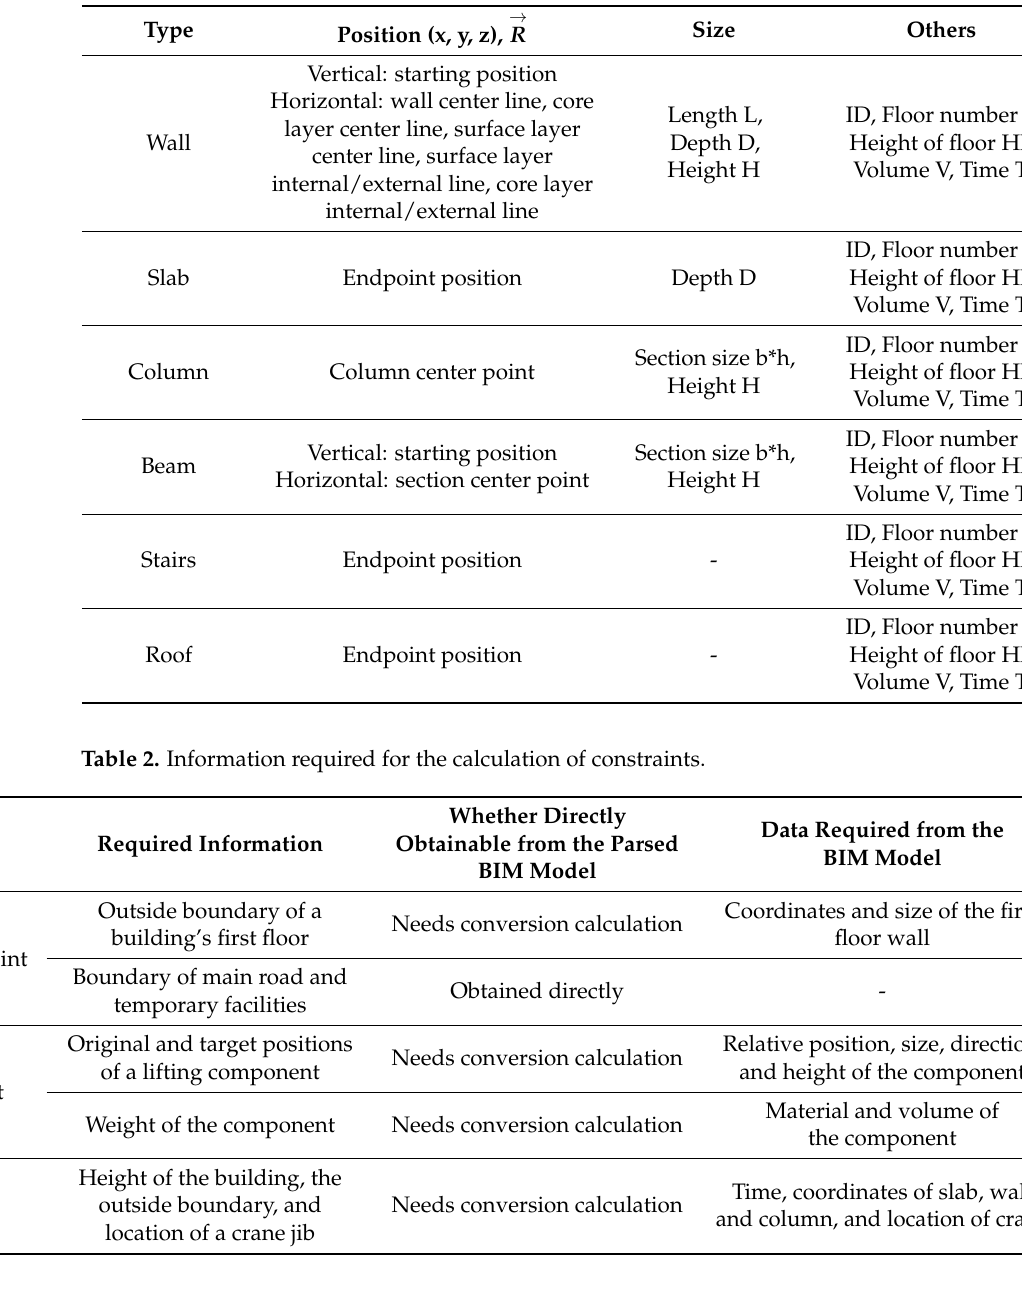
Table 1. Parameter information of building components for crane selection and localization.